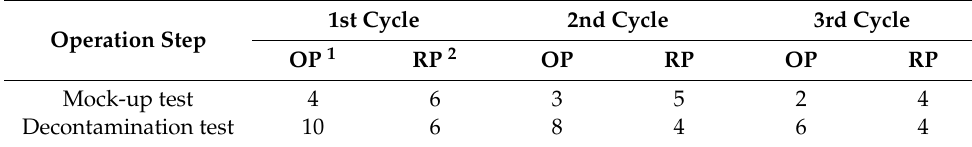
Table 2. Operating time for the mock-up and decontamination test